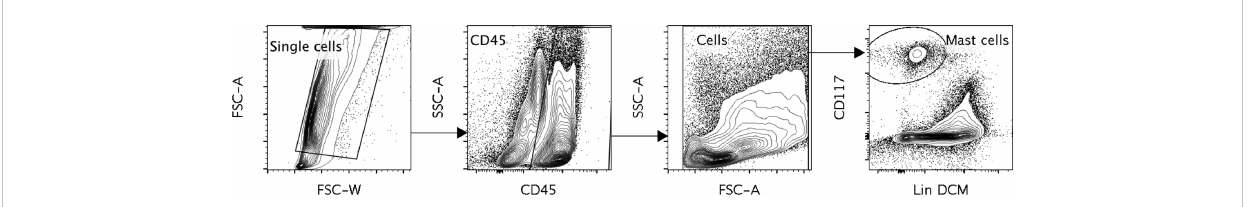
FIGURE 1 A representative fi gure of the gating of the human lung mast cells. Cells were gated as Single cells, CD45 +, cells selected in the FSC, SSC pattern, CD117 high , dead cell marker (DCM) Low and Lineage (Lin) Low . The Lineage markers consisted of CD3, CD14, CD19, CD1a, CD123, BDCA2, TCR a / b , TCR g / d , CD94 and